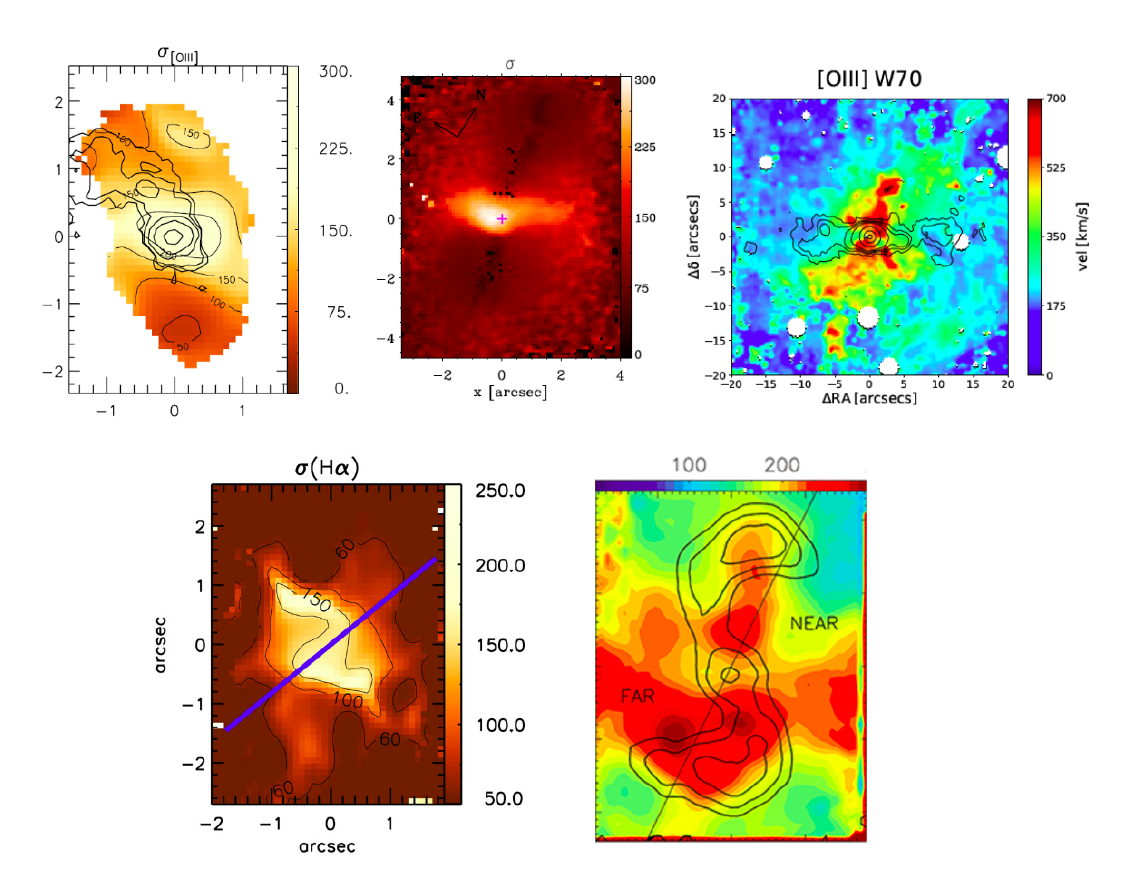
Figure 6. Gas kinematics of several active galaxies displaying increased gas velocity dispersion– attributed to outflowing components–perpendicularly (or close to being perpendicular) to the radio jet orientation. Top left: Arp 102B Gemini GMOS-IFU [O III ] velocity dispersion map, with VLA 8.4 GHz contours displaying the radio jet emission [68]. Top middle: NGC 1386 GMOS-IFU [N II ] velocity dispersion map, with the dark region along north-south axis tracing the jet emission (not shown here) and enhanced integrated flux [61]. Top right: NGC 5643 VLT-MUSE [O III ] W70 map showing highest values perpendicular to the radio jet shown via VLA 8.4 GHz emission contours [19]. Bottom left: 3C 33 H α velocity dispersion map, with the large scale VLA 1.4 GHz radio jet orientation represented by the blue line [92]. Bottom right: NGC 3393 GMOS-IFU [N II ] velocity dispersion map also displaying VLA 8.4 GHz radio emission as black contours [110]. Velocity dispersion and W70 units are in kms − 1